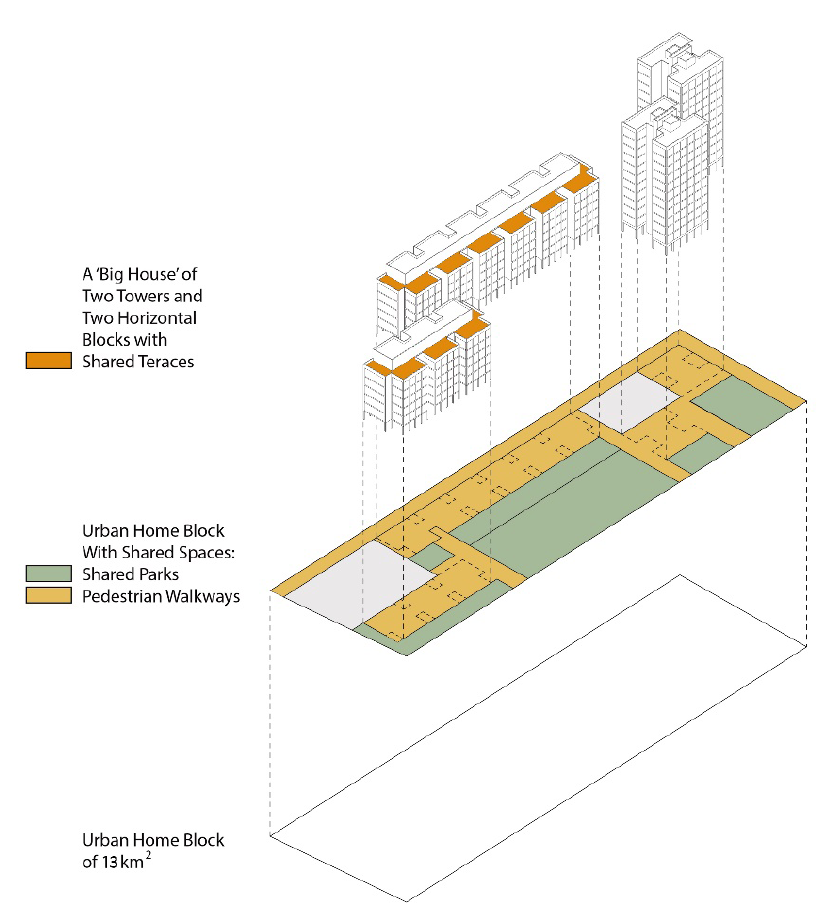
Figure 15. Be’eri estate home-block. Source: